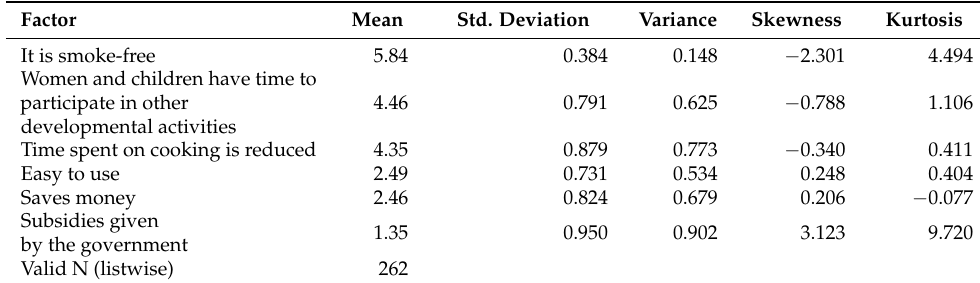
Table 2. Motivating factors toward biogas adoption.